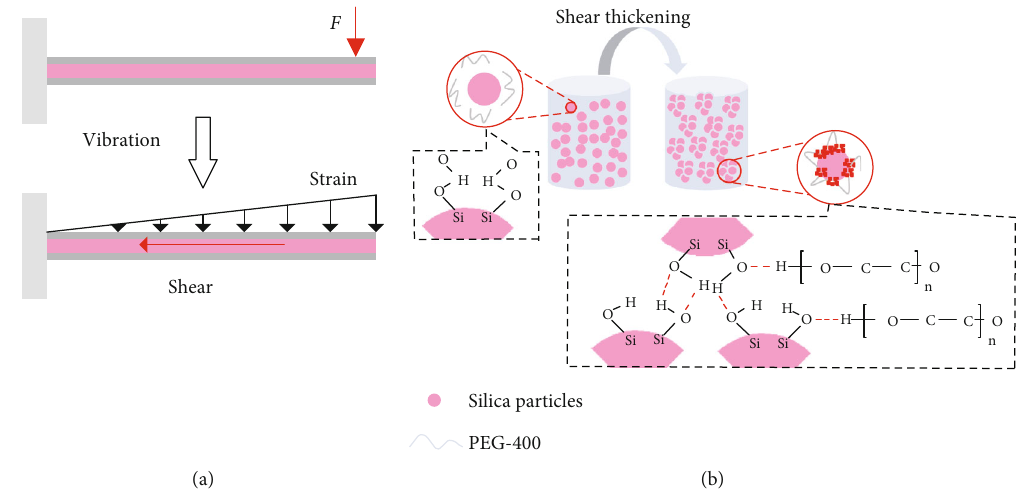
Figure 8: (a) The stress and strain distributions of STF- fi lled sandwich structures during vibration. (b) The thickening mechanism of